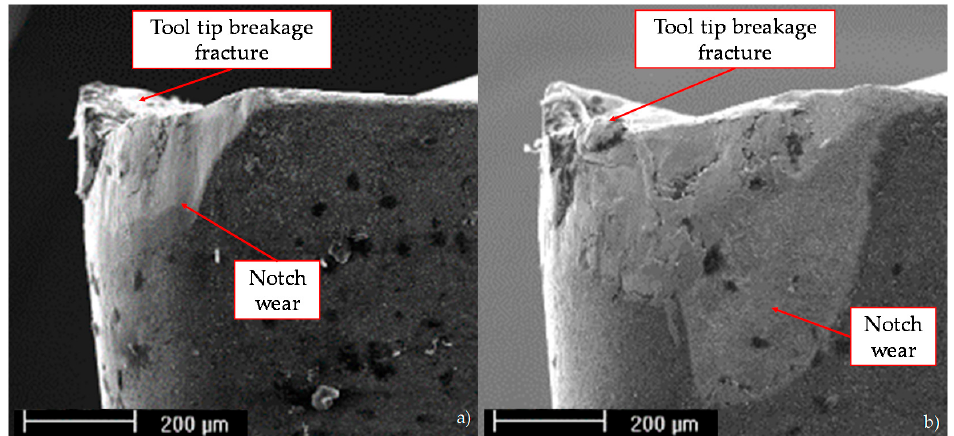
Figure 6. SEM image of carbide tool and the end of tool life ( a ) V c = 50 m/min, f = 0.1 mm/rev ( b ) V c = 70 m/min, f = 0.15 mm/rev.